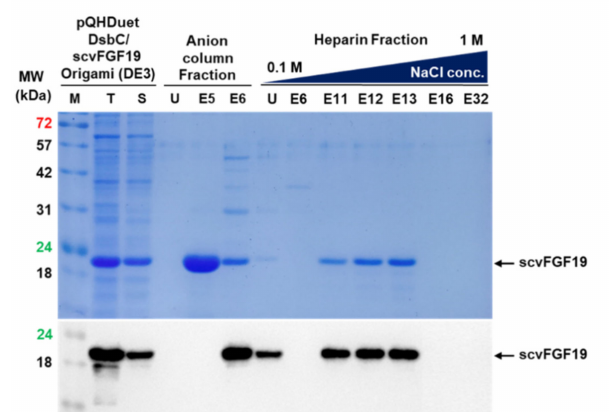
Figure 5. Purification of the codon variant 19 through the successive application of anion exchange and heparin a ffi nity chromatography. M: protein size marker; T and S: total and soluble fraction; U: flow through; E5, E6, E10, E16, E17, E18, and E24: fraction